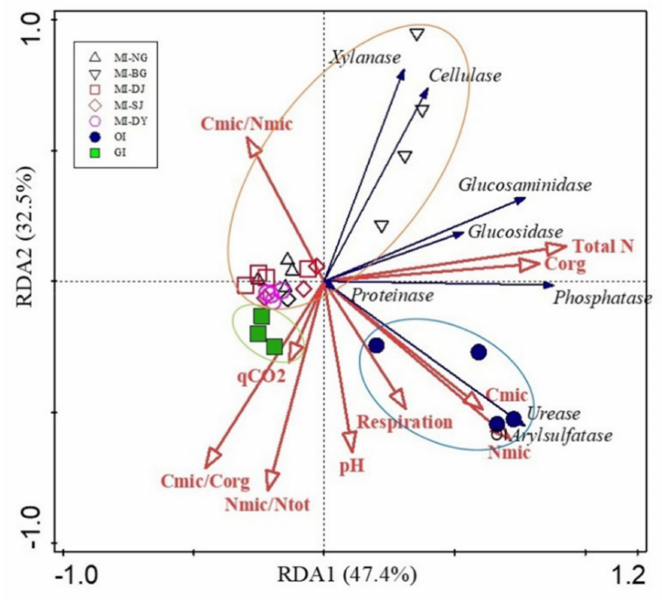
Figure 3. Redundancy analysis (RDA) results of the relationship between soil variables and enzymatic properties of the different islands.